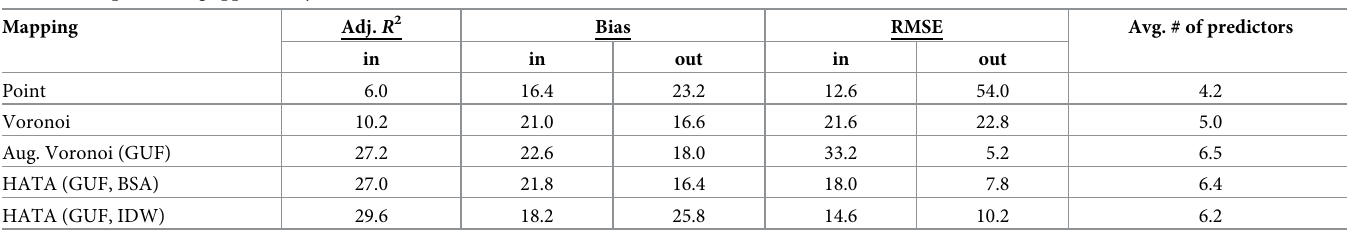
Table 6. Best performing approach by round across rounds